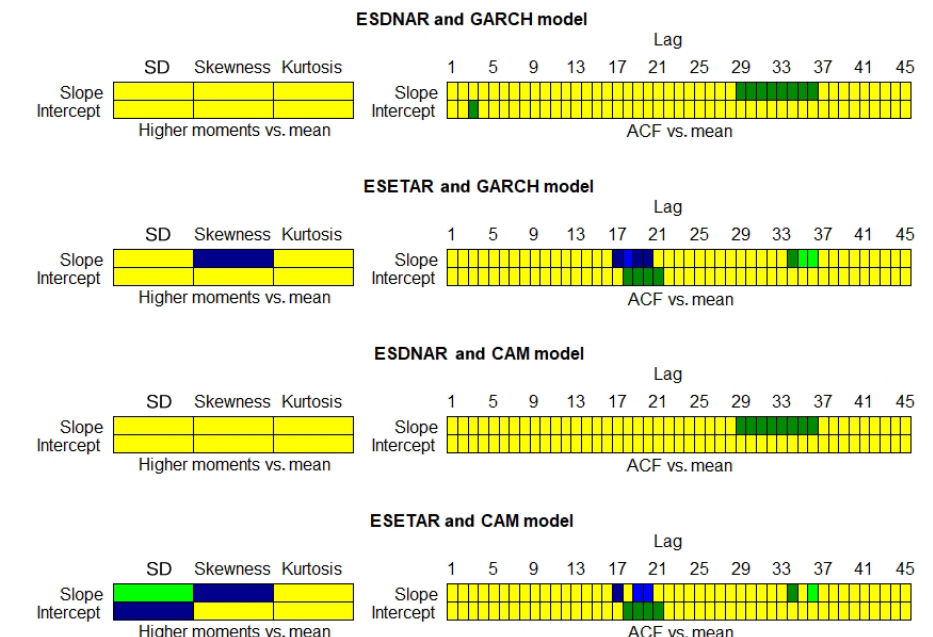
Figure 9. Plots of the ability of the ESDNAR model with GARCH noise, denoted as ESDNAR and GARCH, (first row); the ESETAR model with GARCH noise, denoted as ESETAR and GARCH, (second row); ESDNAR and correlated additive and multiplicative (CAM) noise, denoted as EDSNAR and CAM, (third row); and the ESETAR model with CAM noise, denoted as ESETAR and CAM, (fourth row) models to reproduce the higher moments and sample ACF of the daily NAO winter index. The plots are generated in the same way as the plots in Fig. 5.